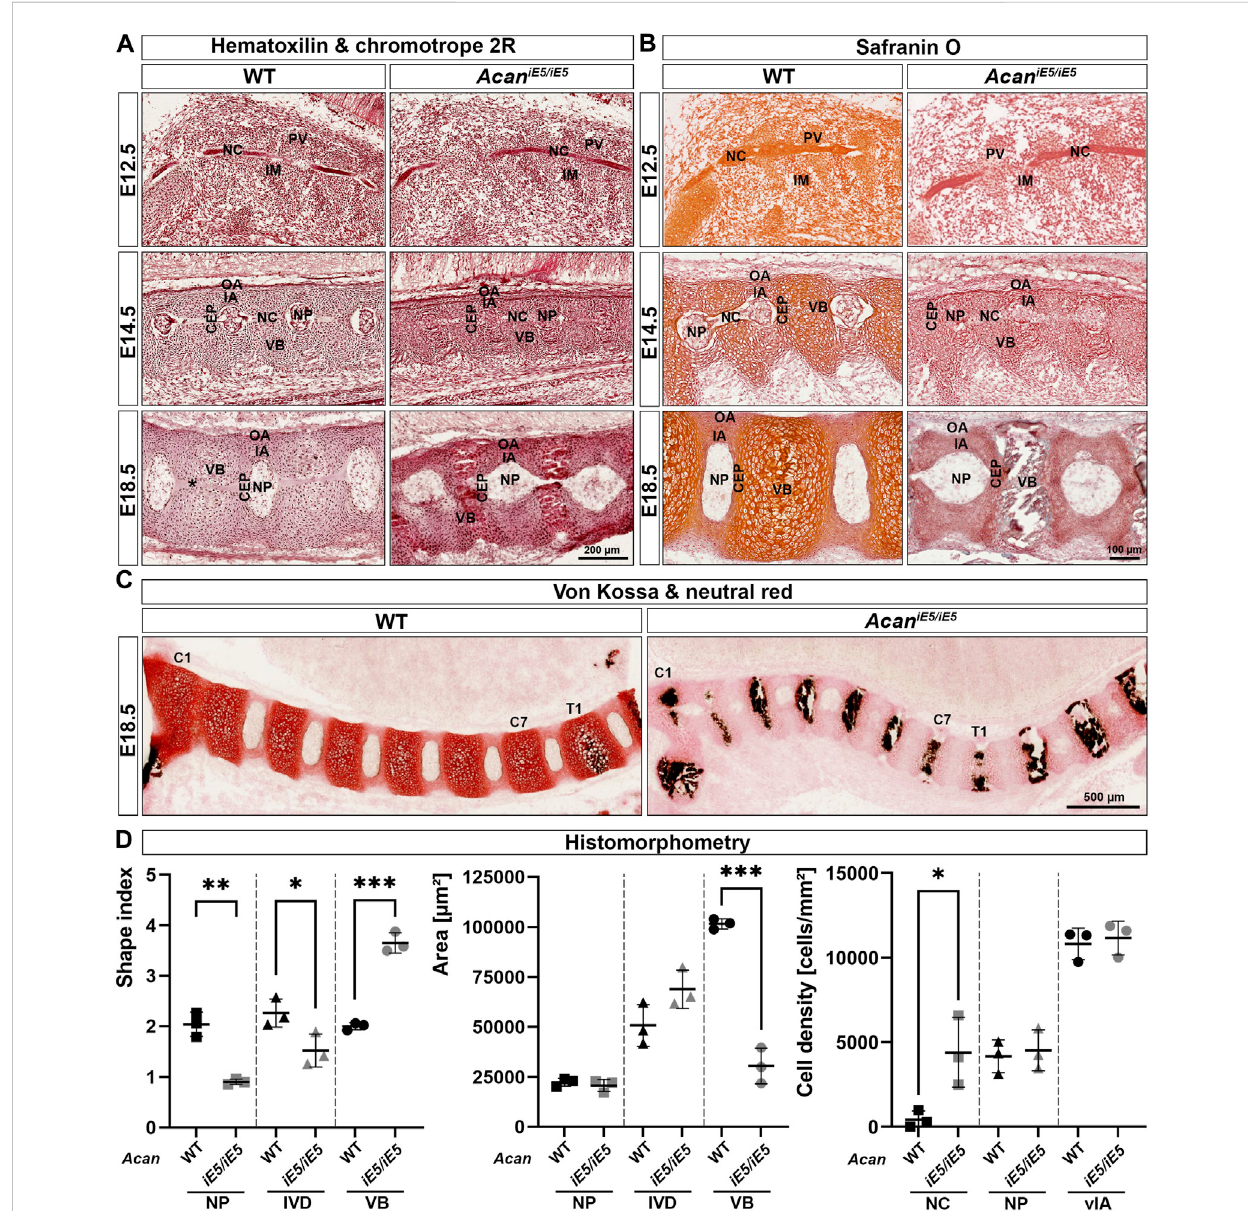
FIGURE 3 (A) Representative images of Hematoxylin and Chromotrope 2R stained cervical vertebral columns in Acan iE5/iE5 and WT mice at E12.5, E14.5 and E18.5. Scale bar, 200 µm. (B) Safranin O staining showing that proteoglycan deposition in the ECM of the spinal column of Acan iE5/iE5 mice is negligibly low. Scale bar, 100 µm. (C) Von Kossa and neutral red staining demonstrating the premature mineralization of the cervical (C1-C7) VBs in mutant mice. Wild type shows black calcium phosphate deposits only from the level of the fi rst thoracic (T1) vertebra. Scale bar, 500 µm. Top-bottom and left- right ofevery picturecorrespond to thedorsal-ventral and rostral-caudal anatomical orientations, respectively. (D) Histomorphometric analysisof shape index, area and cell density of the depicted spine compartments of E18.5 animals. Abbreviations: NC, notochord; IM, intervertebral mesenchyme; PV, prevertebrae; NP, nucleus pulposus; VB, vertebral body; CEP, cartilage end plate; IA, inner annulus fi brosus; vIA, ventral IA; OA, outer annulus fi brosus. Data represent the mean ± STD. Statistical signi fi cance calculated by unpaired t -test, where *: p ≤ 0.05; **: p < 0.01 and ***: p <